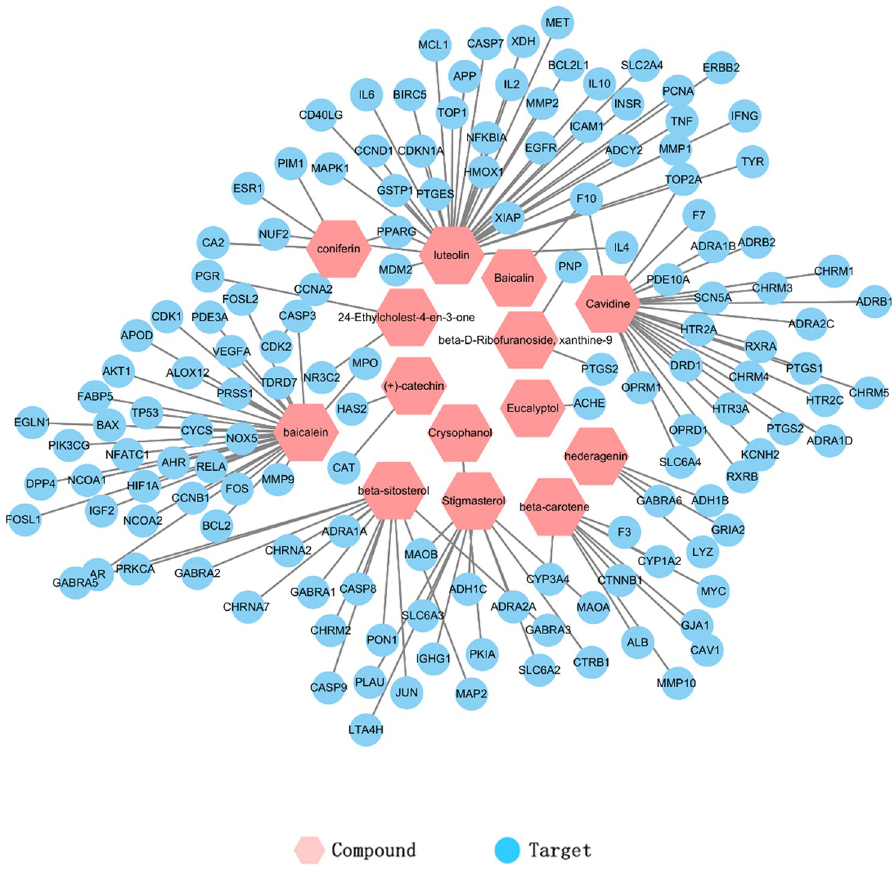
Fig 2. Compounds-target network. Pink hexagons represent compounds and blue circles represent targets.